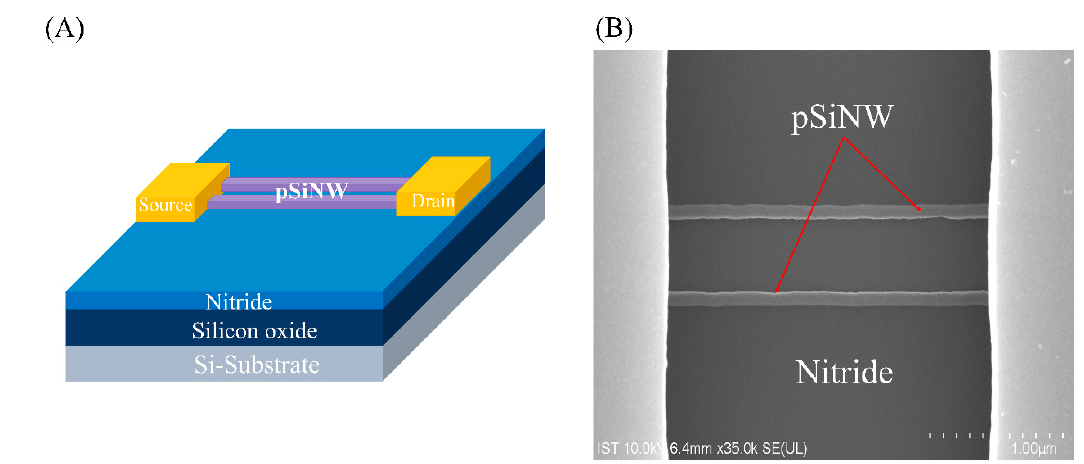
Figure 1. Schematic diagram and SEM images of the pSiNWs structure. ( A ) The schematic diagram of a pSiNWFET structure includes the layer of silicon oxide, nitride, source/drain, and two pSiNWs (not in scale). ( B ) The SEM image of a device from top-view with 35 k of magnification. The two pSiNWs lengths and widths were 2.43 µM and 94 nm, respectively.